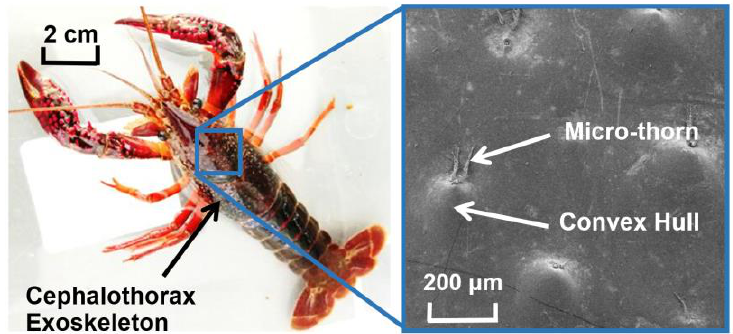
Figure 1. Microstructure of Cephalothorax exoskeleton of the Procambarus clarkii. The special surface structure and excellent wear resistance behavior of Procambarus clarkii Cephalothorax exoskeleton provide an excellent natural blueprint prototype for innovative bionic wear resistance surface design. In this study, based on the wear resistance theory of a bionic non-smooth surface [38,39], as shown in Figure 2, three bionic non-smooth geometrically structured surfaces were designed by learning from the micro-thorn and convex hull coupled structured surface on the cephalothorax exoskeleton of Procambarus clarkia . They were bionic single (Bionic Type 2), double (Bionic Type 3) and triple (Bionic Type 4) micro-thorn and convex hull coupled structured surface. To compare the performance of abrasive wear resistance, a convex hull structured surface (Bionic Type 1) and conventional smooth surface without any structures (Smooth) were used as control. The SolidWorks software was used for three-dimensional modeling; a high-precision 3D printer (Wiiboox One, Wiiboox 3D Technology Co., Ltd., Nanjing, China) was used to prepare experimental samples. The sectional dimensions of the samples were 60 × 40 mm, and the height was 4 mm.